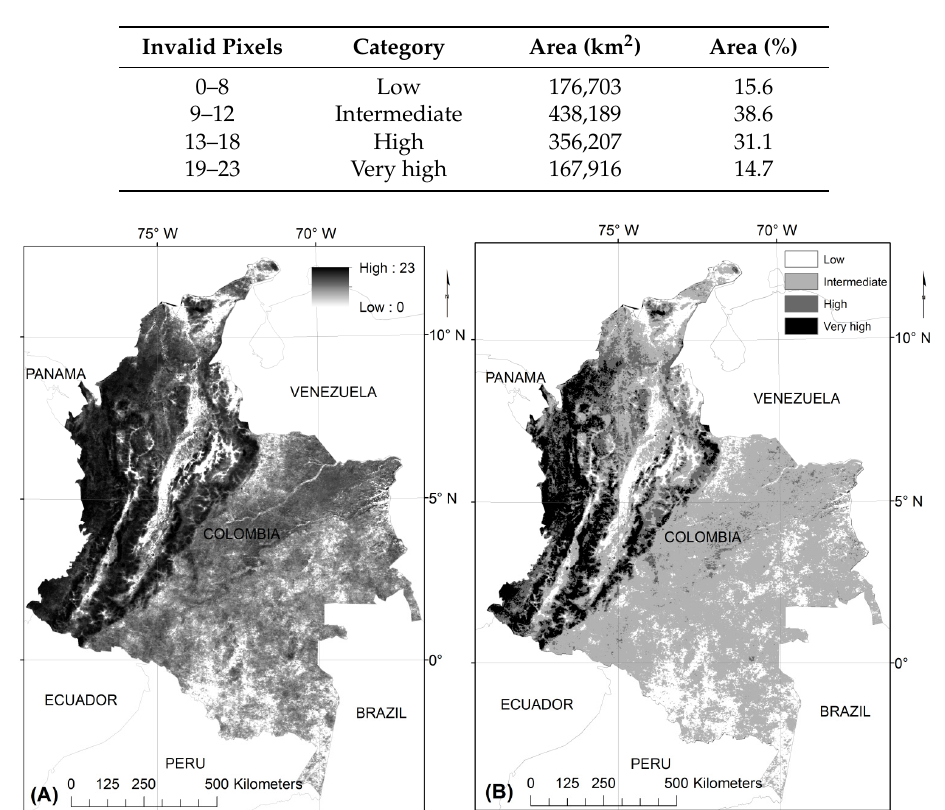
Figure 3. Spatial distribution ( A ) of invalid pixels for 2011 with dark areas showing high frequency (maximum 23 composites per year) and ( B ) depicting a categorization into four classes using natural breaks (Jenks) unsupervised clustering for data ranges (see Table 4).